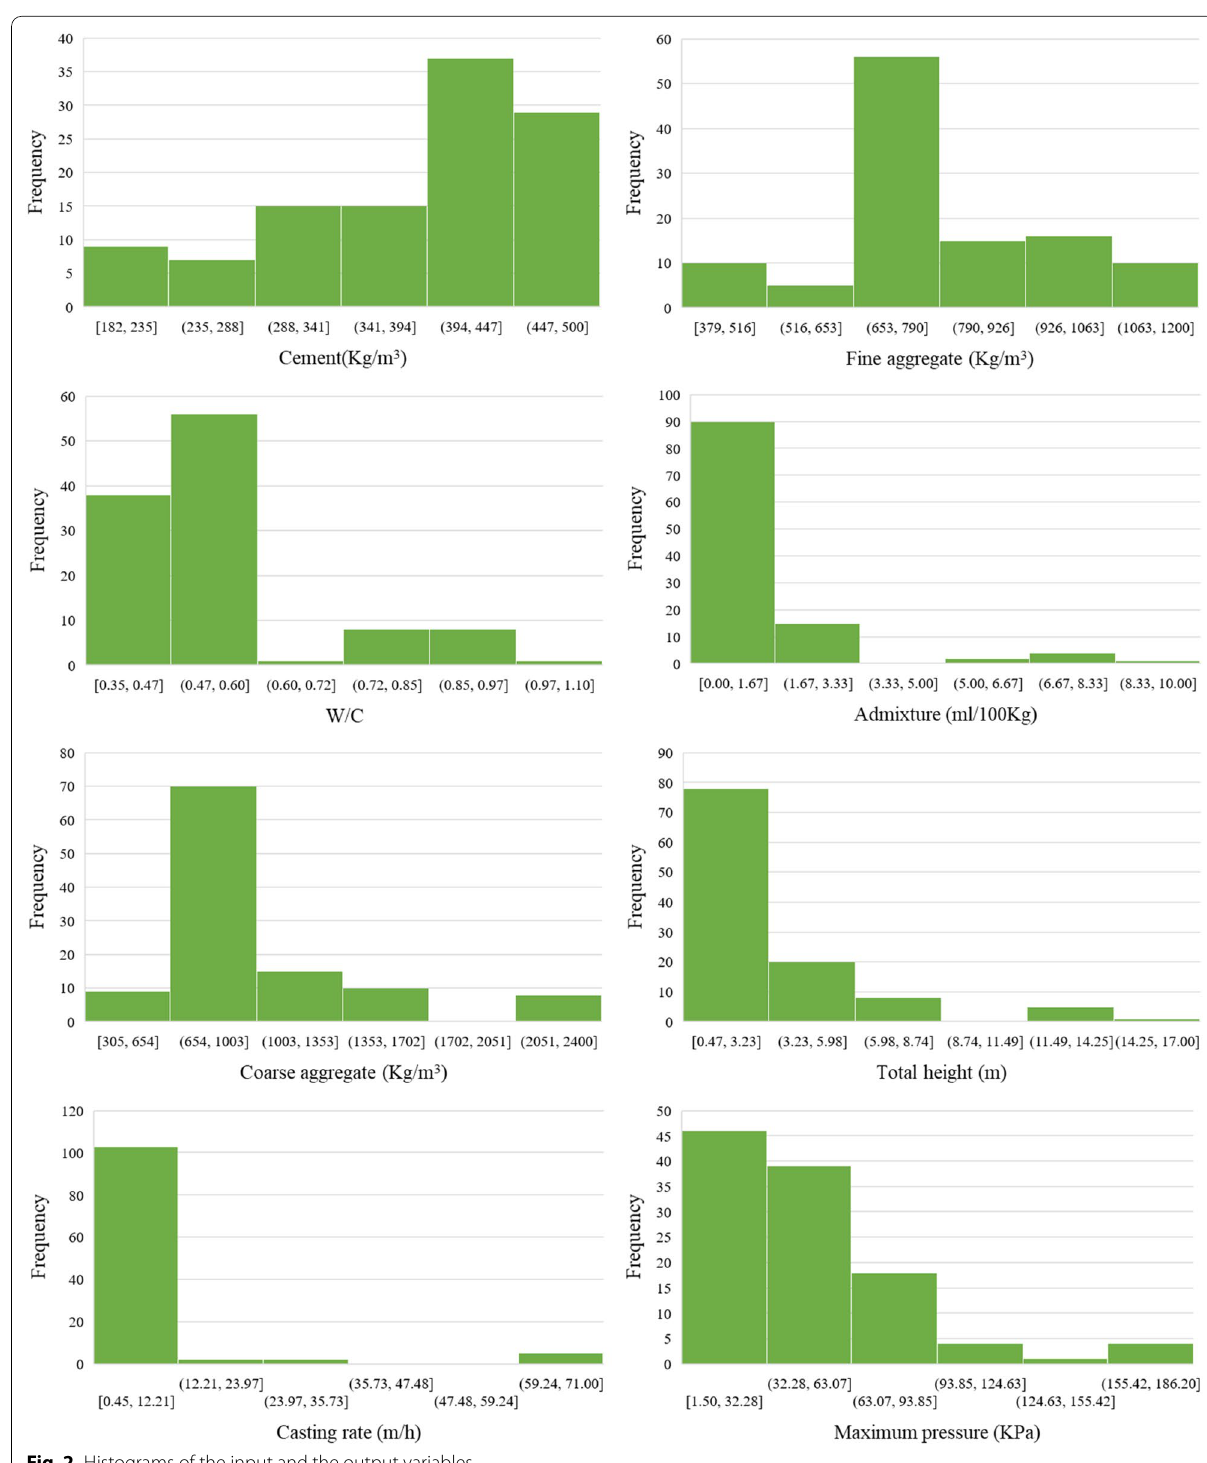
Fig. 2 Histograms of the input and the output